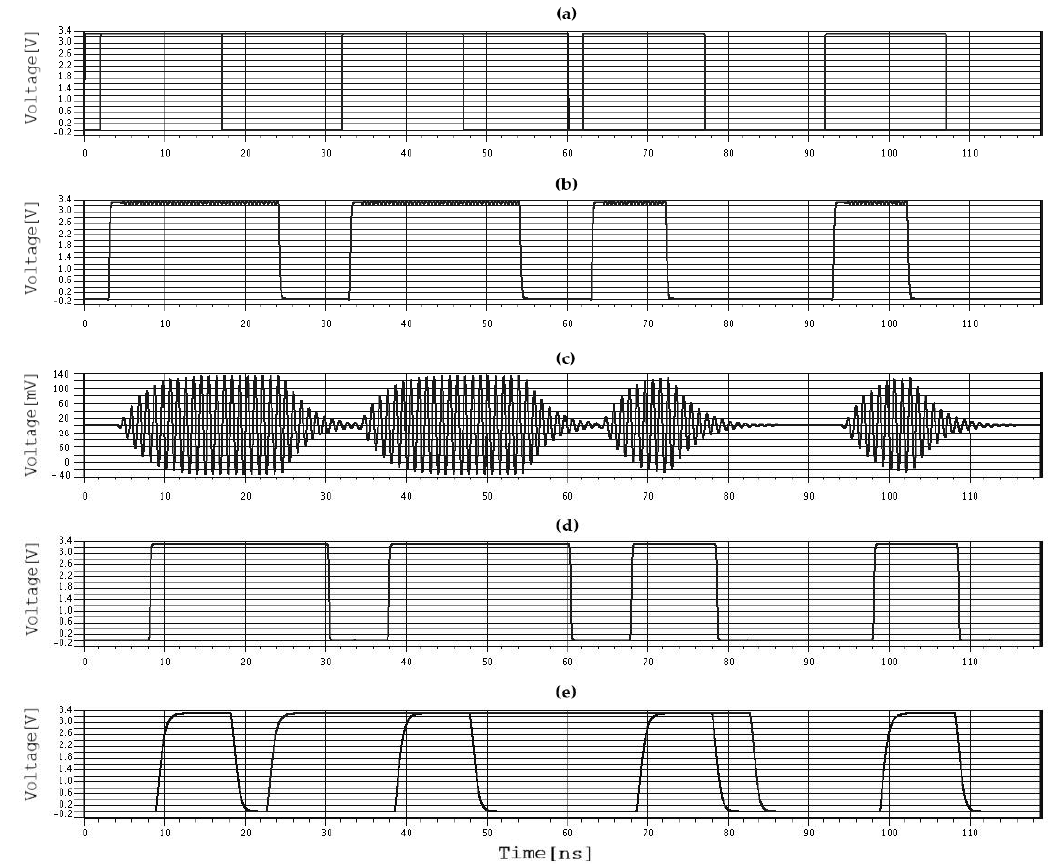
Figure 18. ( a ) CK IN and D IN ; ( b ) PWM IN ; ( c ) RX antenna signal; ( d ) PWM OUT ; ( e ) CK OUT and D OUT ( f D = 33 Mb/s).